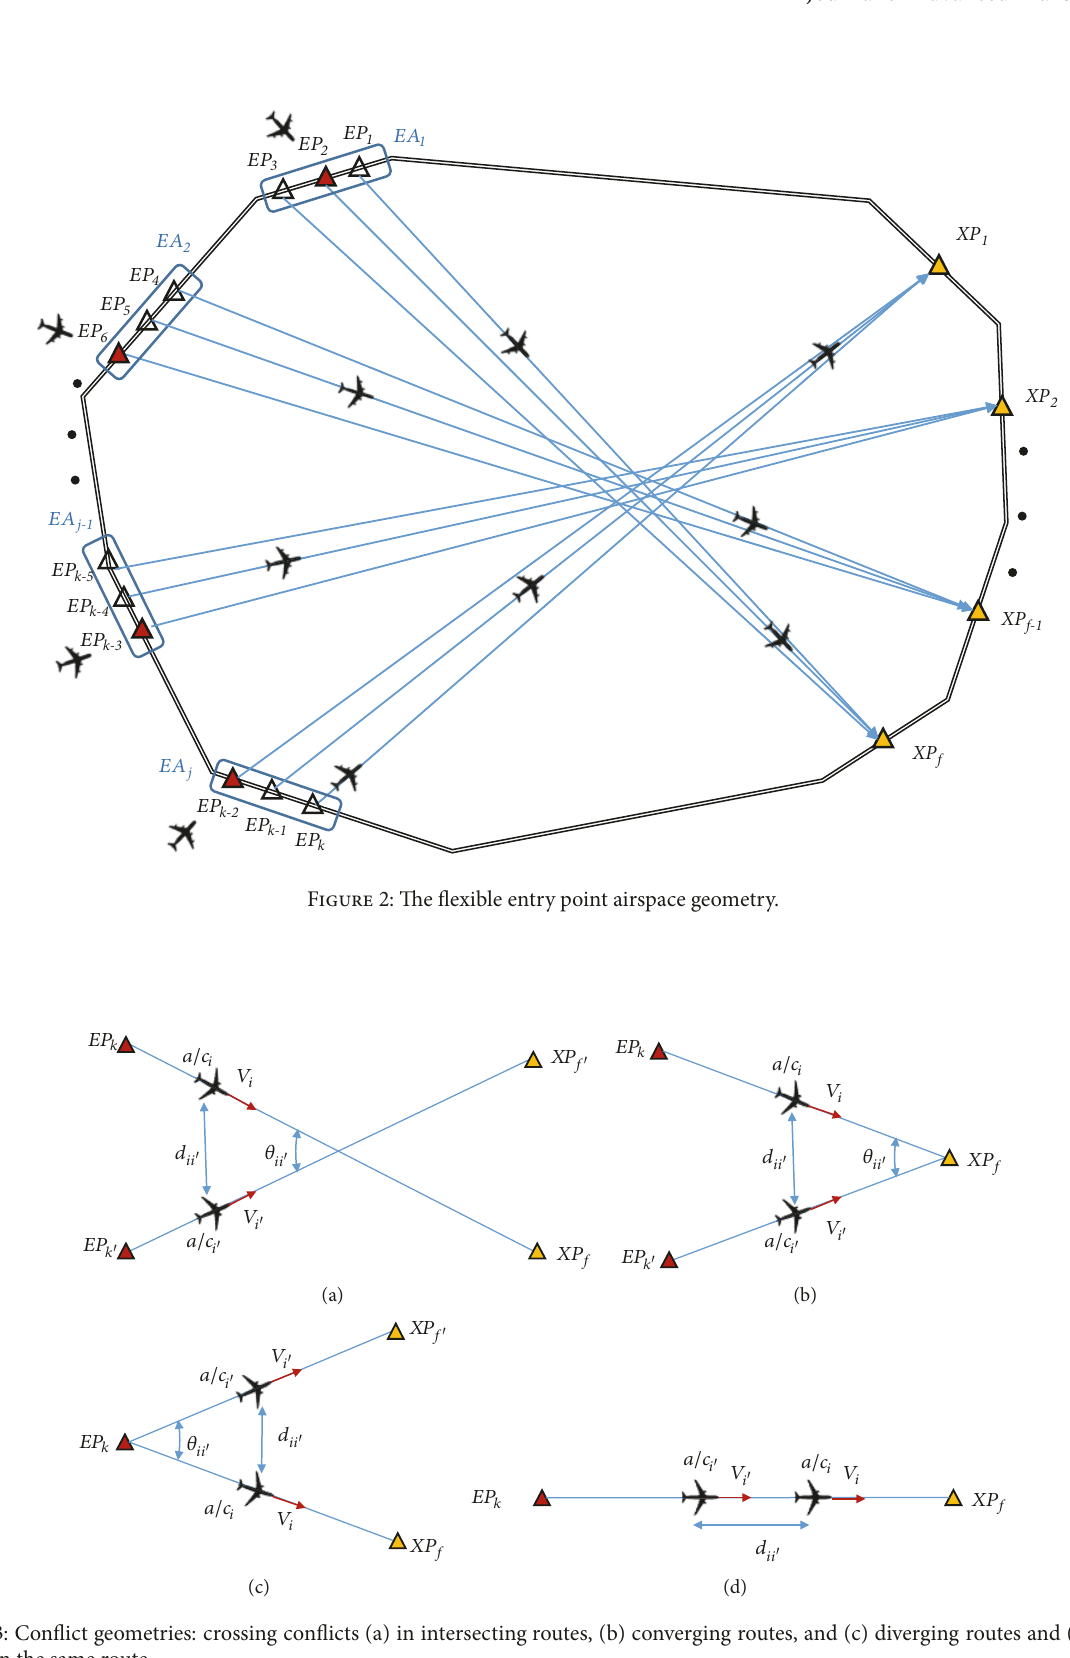
Figure 3: Conflict geometries: crossing conflicts (a) in intersecting routes, (b) converging routes, and (c) diverging routes and (d) trailing conflict in the same